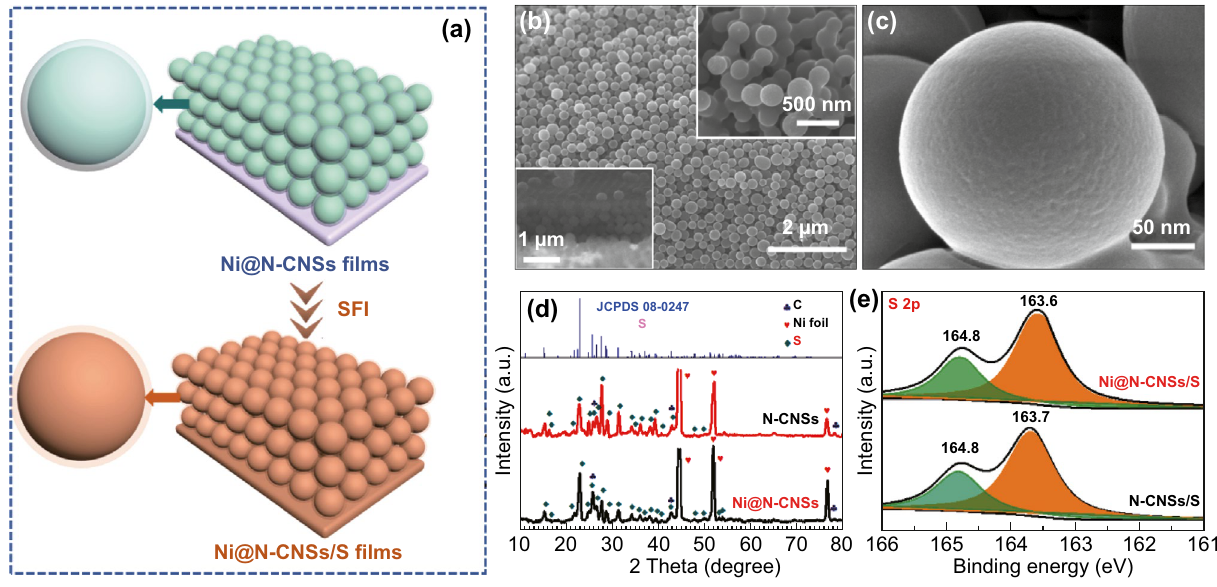
Fig. 4 a Schematic fabrication process of Ni@N-CNSs/S electrode. b, c SEM images of Ni@N-CNSs/S electrode. d XRD patterns and e S 2 p XPS spectra of N-CNSs/S and Ni@N-CNSs/S